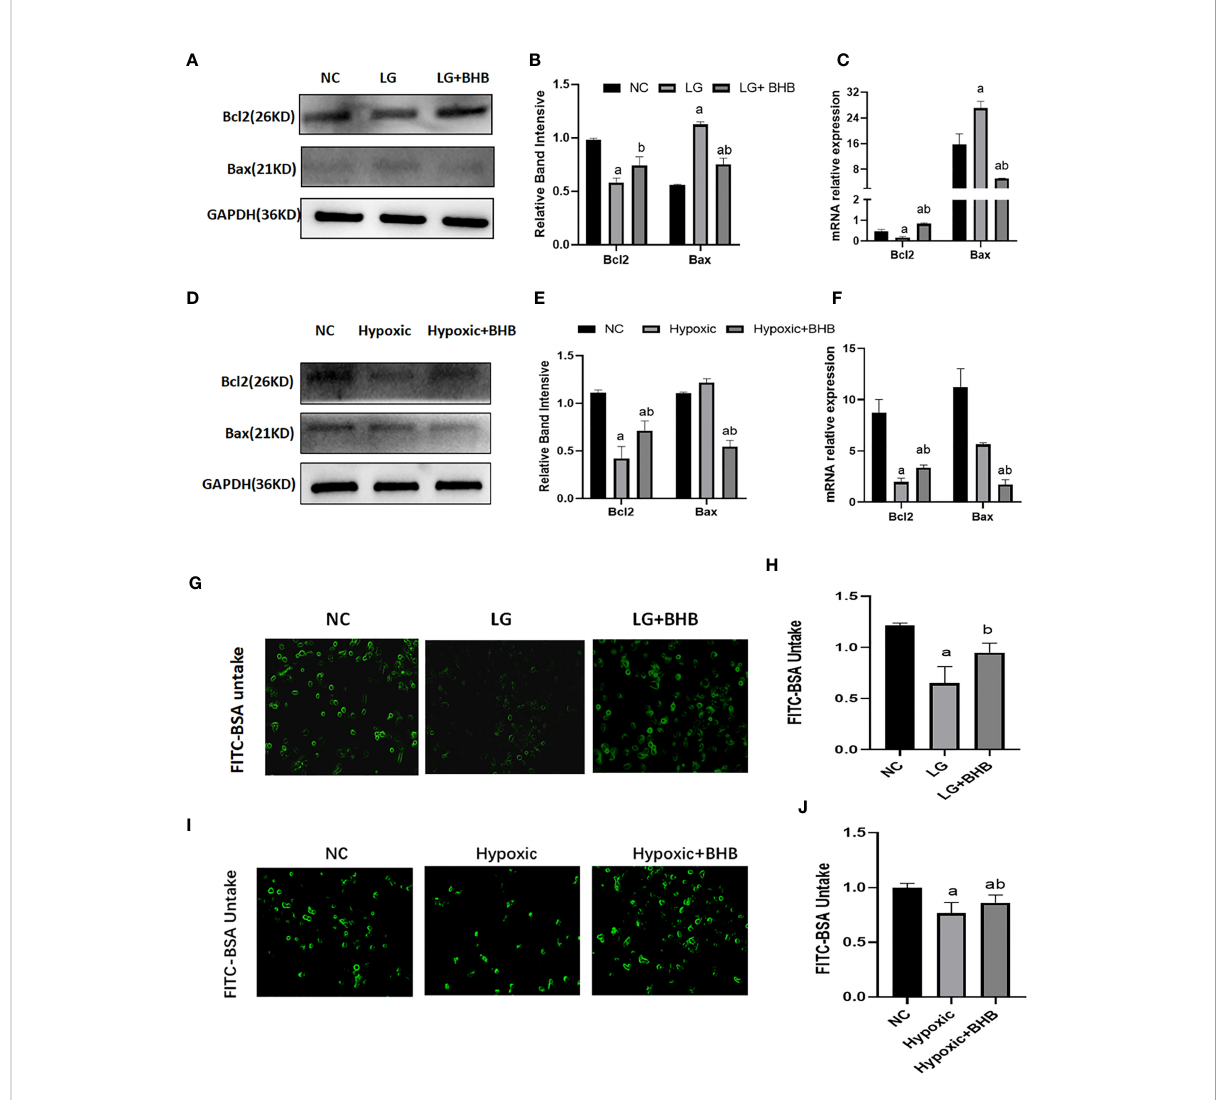
FIGURE 6 Effect of BHB on apoptosis and albumin endocytosis in HK2 cells under hypoglycemic and hypoxic conditions. (A, D) Expression of Bcl-2 and Bax; (B, E) Quantitative results of Bcl-2 and Bax proteins; (C, F) Quantitative results of Bcl-2 and Bax gene expression; (G, I) Changes of endocytic albumin in different groups detected by fl uorescence microscopy; (H, J) Changes of endocytic albumin in different groups detected by a microplate reader. In panels (B, C, H) a p < 0.05, compared with the NC group; b p < 0.05, compared with the LG group; in panels (E, F, J) a p < 0.05, compared with the NC group; b p < 0.05, compared with the Hypoxic